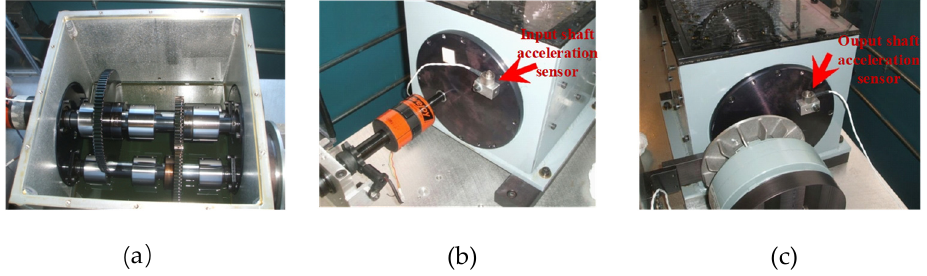
Figure 4. Installation diagram of test gearbox and sensor.( a ) The structure of the test gearbox;( b ) Input shaft acceleration sensor installation position; ( c ) Output shaft acceleration sensor installation location.